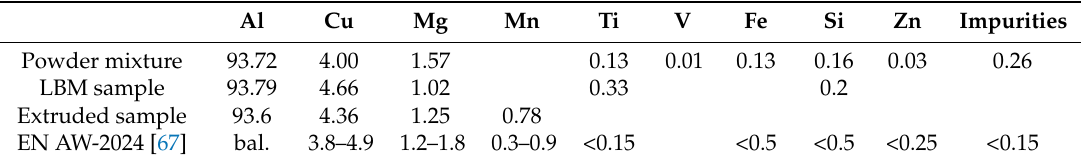
Table 3. Chemical composition in wt% of quaternary powder mixture calculated from mixture composition and XRF measurements of single powders, compared to in situ alloyed LBM sample measured by EDX, extruded sample measured by EDX and standard definition of EN AW-2024